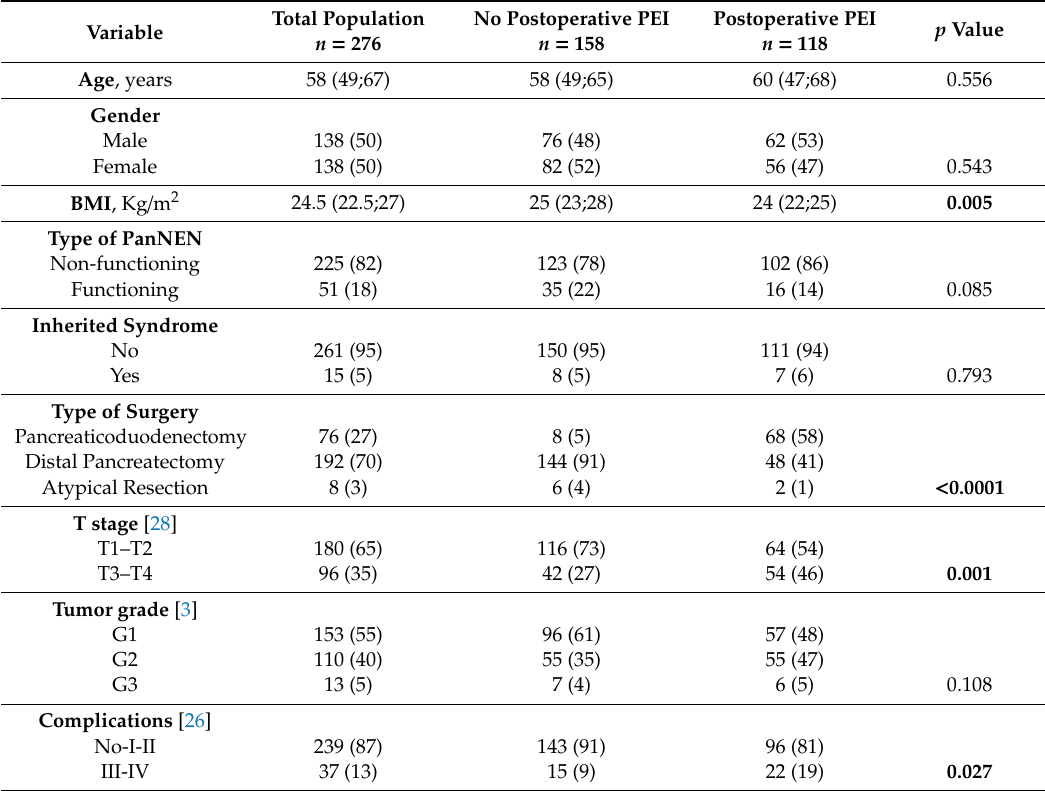
Table 4. Comparison of demographic, clinical and pathological characteristics between patients submitted to surgery for pancreatic neuroendocrine neoplasms (PanNEN) who developed postoperative pancreatic exocrine insu ffi ciency (PEI) (n = 118) and those who did not (n =